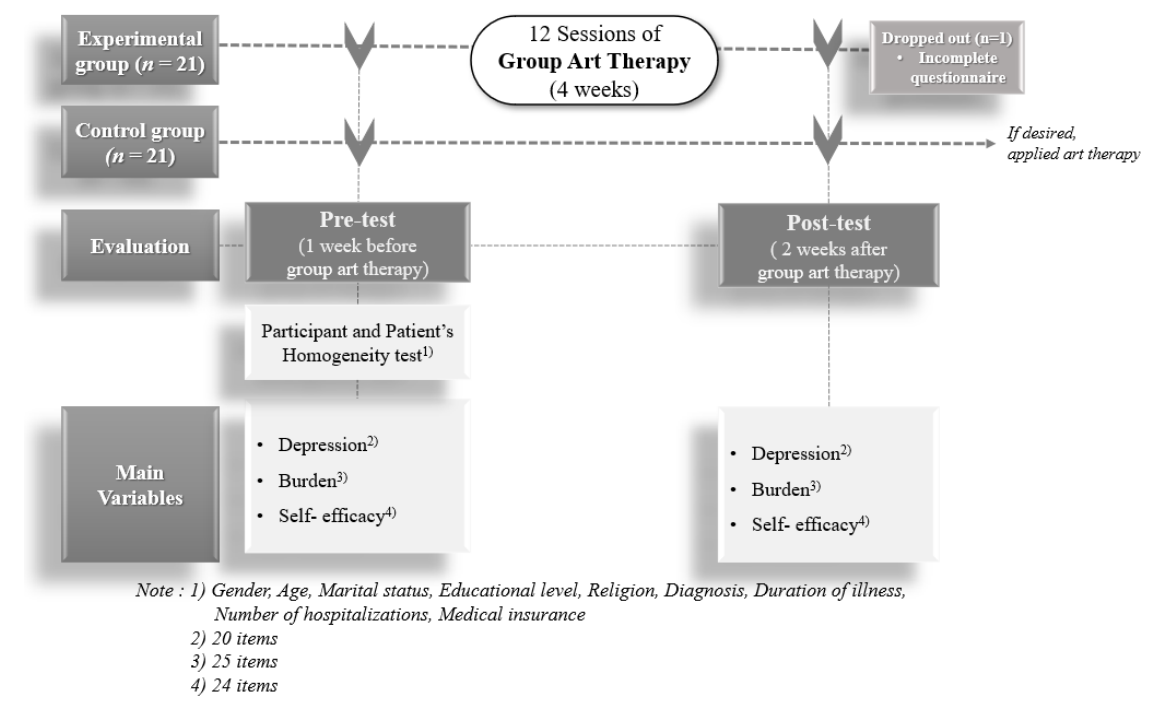
Figure 3. Study process.